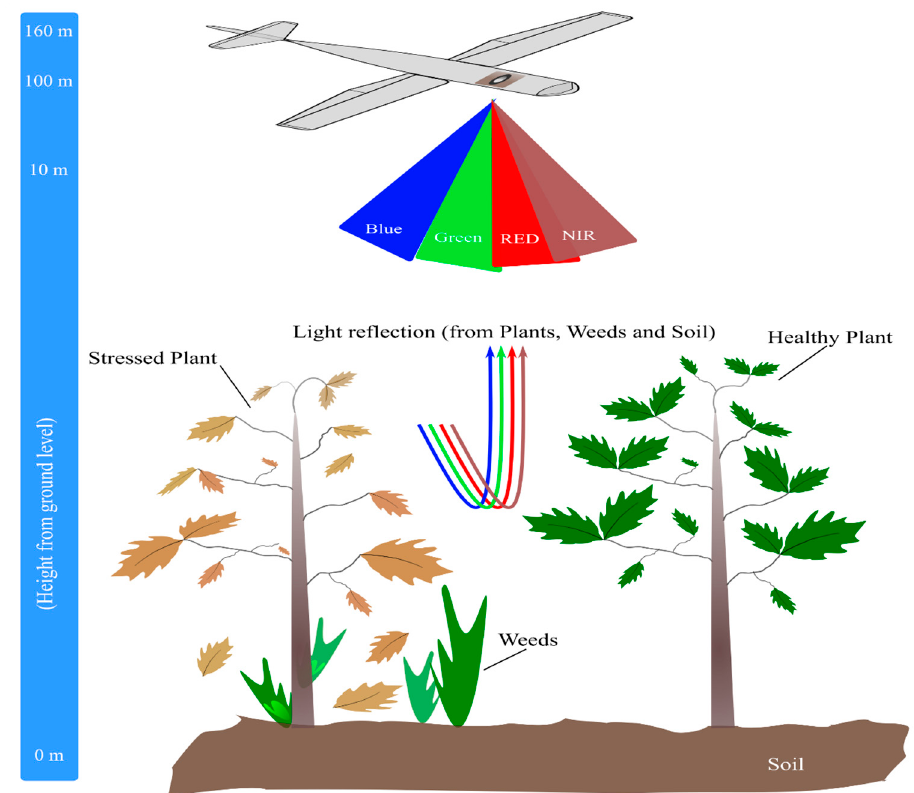
Figure 6. A basic illustration for a drone equipped with multispectral camera (with NIR and RGB bands) and other sensors that uses the light absorbance and reflection from vegetation and soil to generate data that on further analysis produce useful information about weeds, crops and soil.